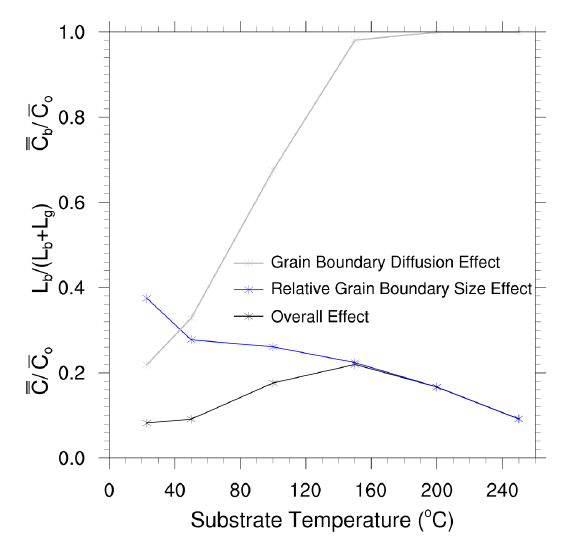
Figure 13. Prediction of the overall concentration of sodium in the bulk of the Mo thin films, assuming the sodium concentration profile in the grain boundary follows an exponential function